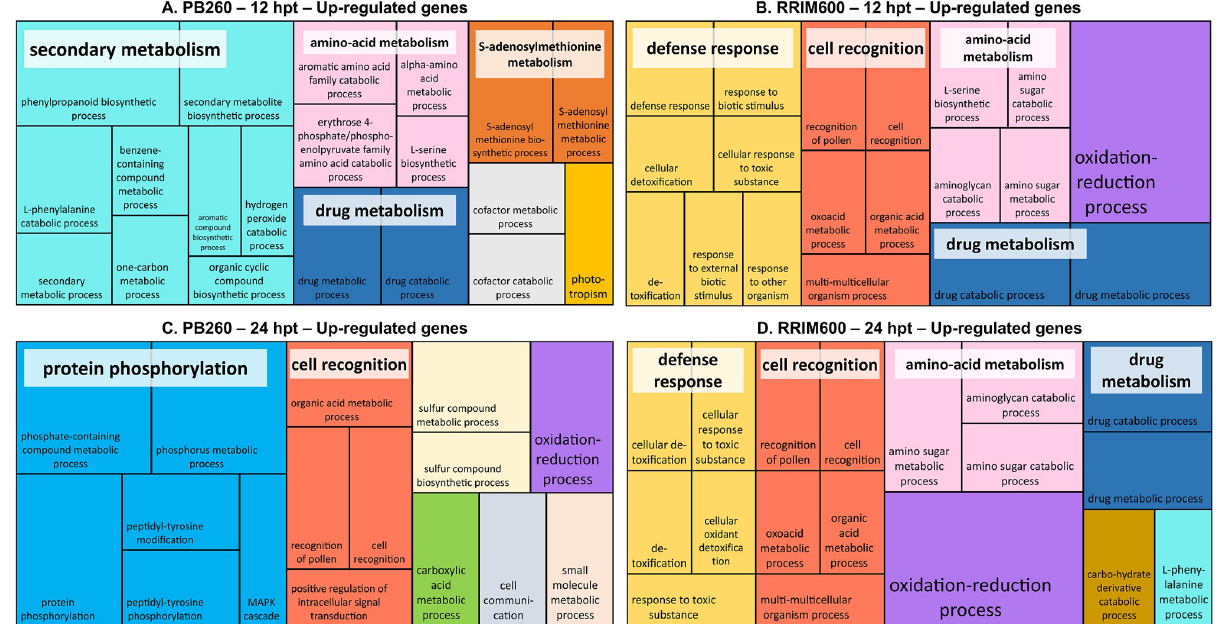
respectively. The same analysis performed in the molecular function (MF) was presented as S5 and S6 Figs. Among the up-regulated genes, GO enrichment in the BP category (Fig 3) revealed that both clones share several superclusters, although with time-frame shifts. The ‘cell recognition’ and ‘oxidation-reduction processes’ superclusters appeared earlier in RRIM600 (panel B) than in PB260 (panel C). They are the only two superclusters shared by both clones at 24 hpt (panel